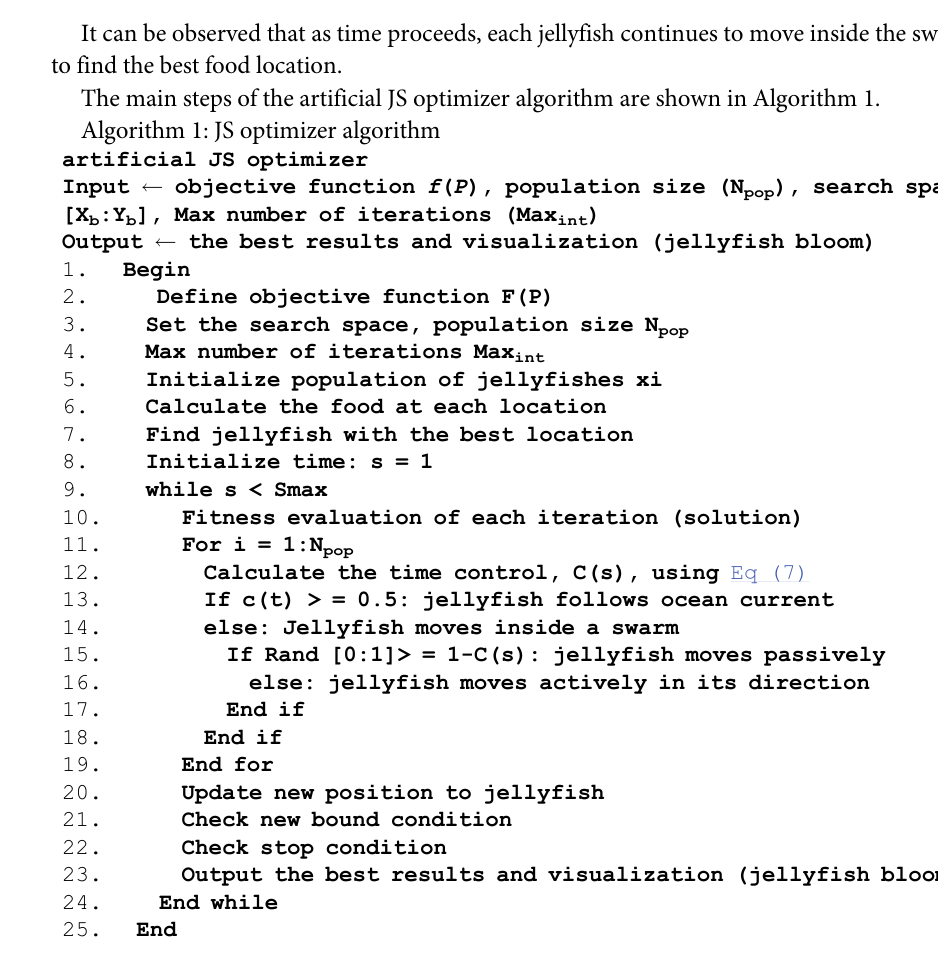
Algorithm 1: JS optimizer